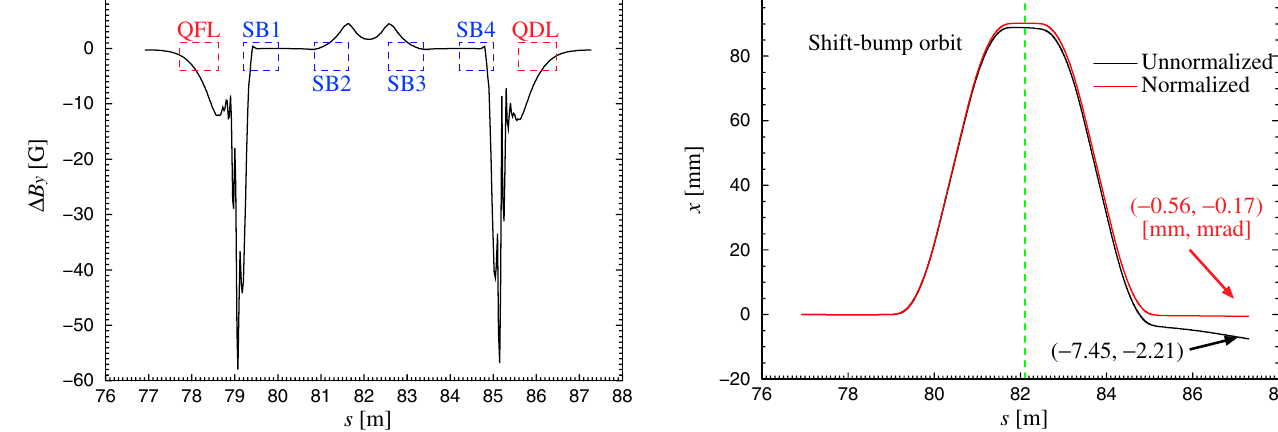
FIG. 5. (Color) Central orbit trajectory in the shift-bump area, which began from x (cid:4) y (cid:4) 0 . The black line shows the orbit of a test particle with the unnormalized field data, the red line shows the case after the Bl normalization, and the green dashed line indicates the stripping foil position ( s (cid:4) 82 : 113 m ).